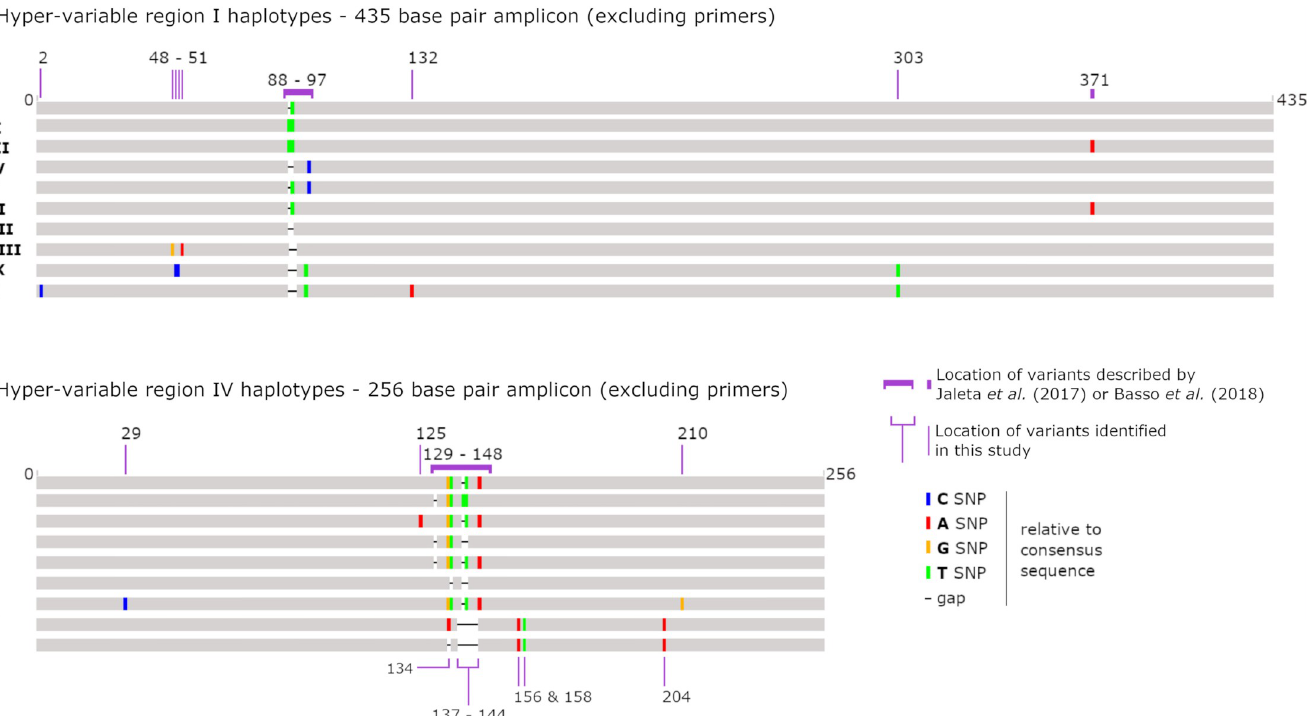
Fig 2. Schematic detailing the proposed modifications to the previously described S . stercoralis genotyping scheme. A graphical representation of the novel Strongyloides haplotypes discovered in this study compared to haplotypes identified in previous reports. The location of sites that were genotypically informative based on the original genotyping method described by Jaletta et al . (2017) and Basso et al . (2018) are indicated, as well as new SNP/indel sites that have been incorporated into the typing scheme based on the results of this study [21, 23]. For hypervariable region I, we introduce two novel types (VIII and X), and assign new haplotype names to published sequences that had not been previously considered in this typing scheme (VII and IX). For hypervariable region IV, we introduce three novel types (E, F, G and I), and assign new haplotype names to published sequences that had not been previously considered in this typing scheme (C, D and H) (see Tables 3 and 4 for